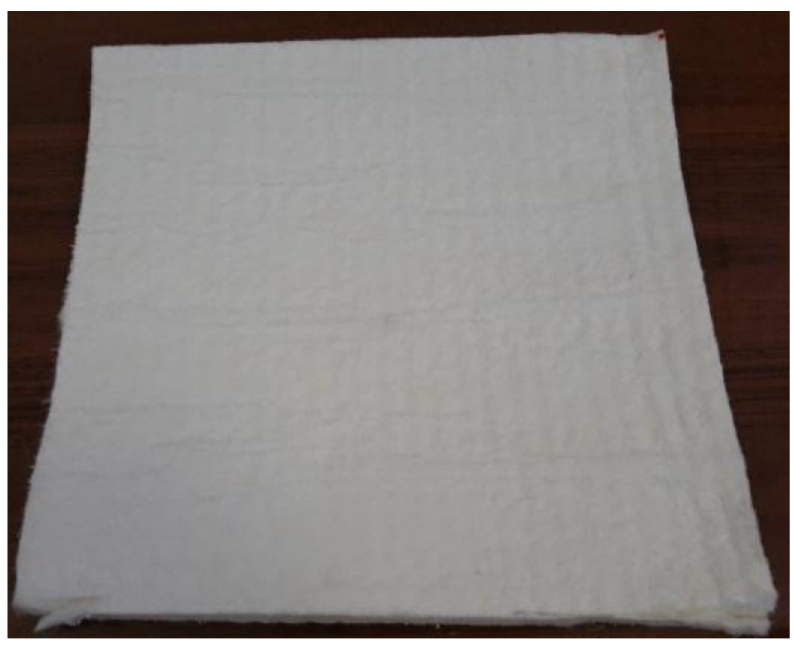
Figure 2. Tested Slentex aerogel insulation. Table 2. Thermal conductivity test results of the Slentex aerogel.